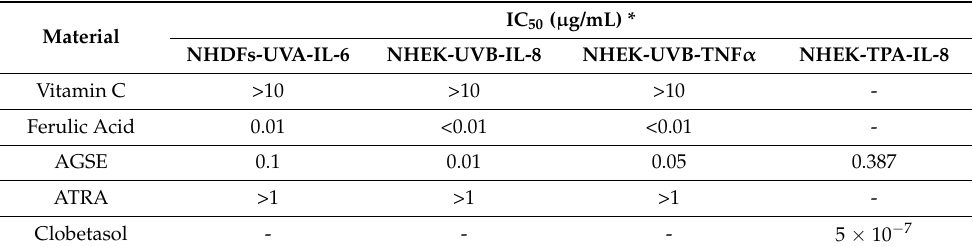
Table 3. Summary of inflammatory assay IC 50